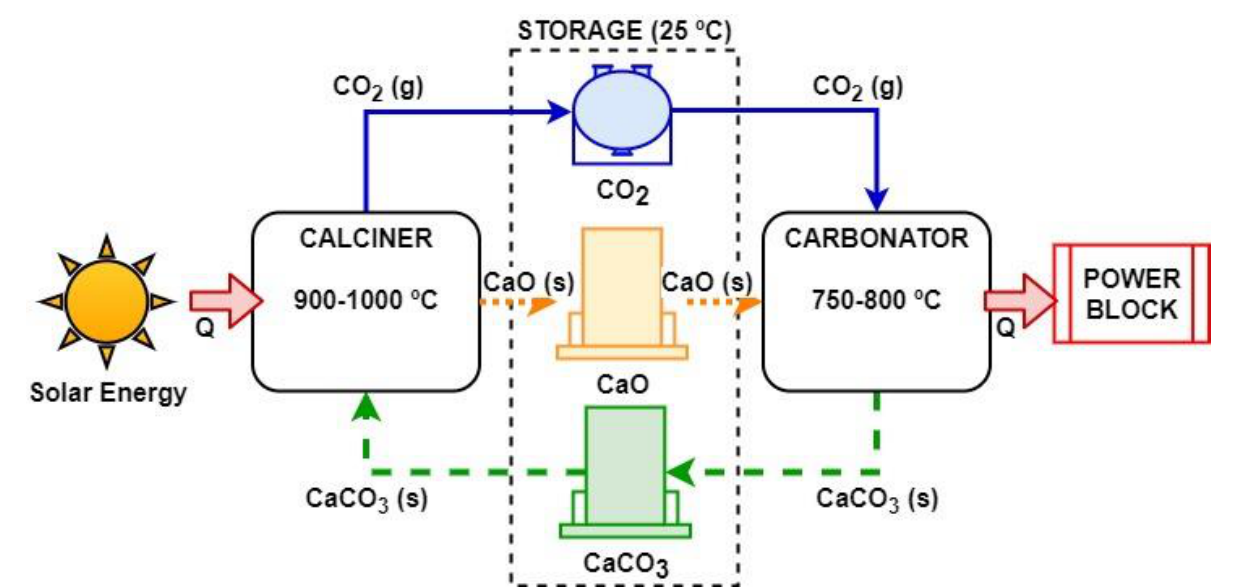
Figure 1. CSP–Calcium Looping conceptual scheme. Adapted from Reference [8].